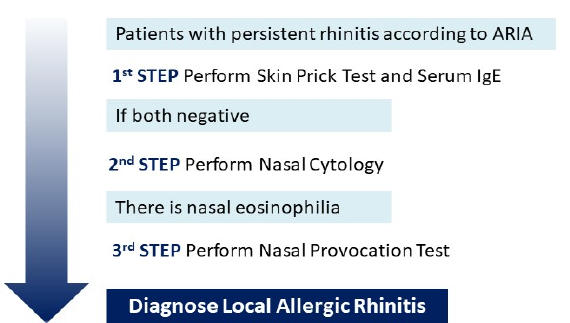
Figure 2. We suggest that nasal cytology analysis could be used as a screening tool for the diagnosis of LAR for those patients with persistent rhinitis according to ARIA and negative skin prick test and serum IgE. Successively, patients with eosinophil nasal inflammation should perform NPT to confirm LAR. LAR Local Allrergic Rhinitis; NPT Nasal Provocation